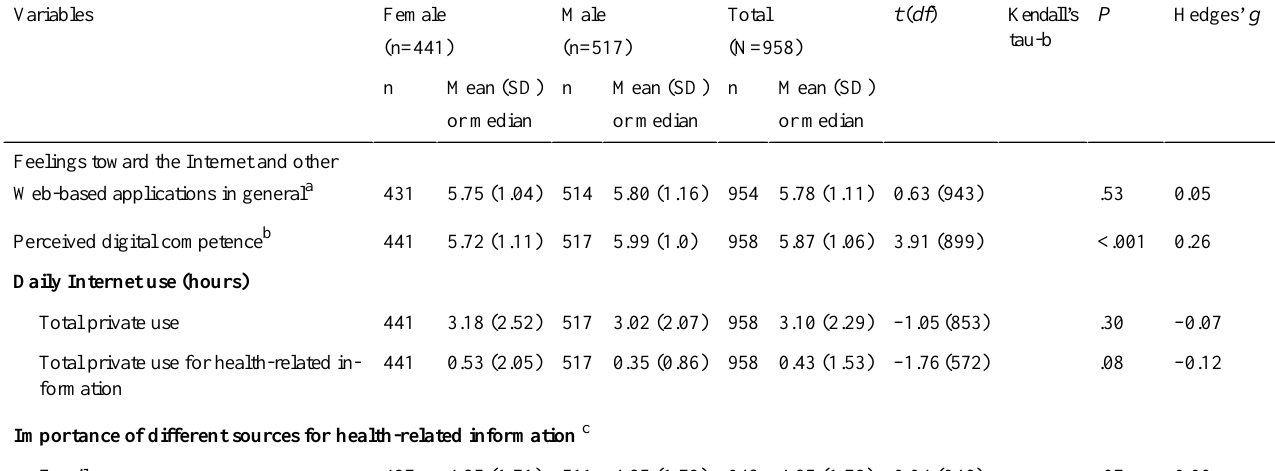
Table 2. Gender differences in Internet health information search behavior, emotions, and cognitions influencing Internet health-related information